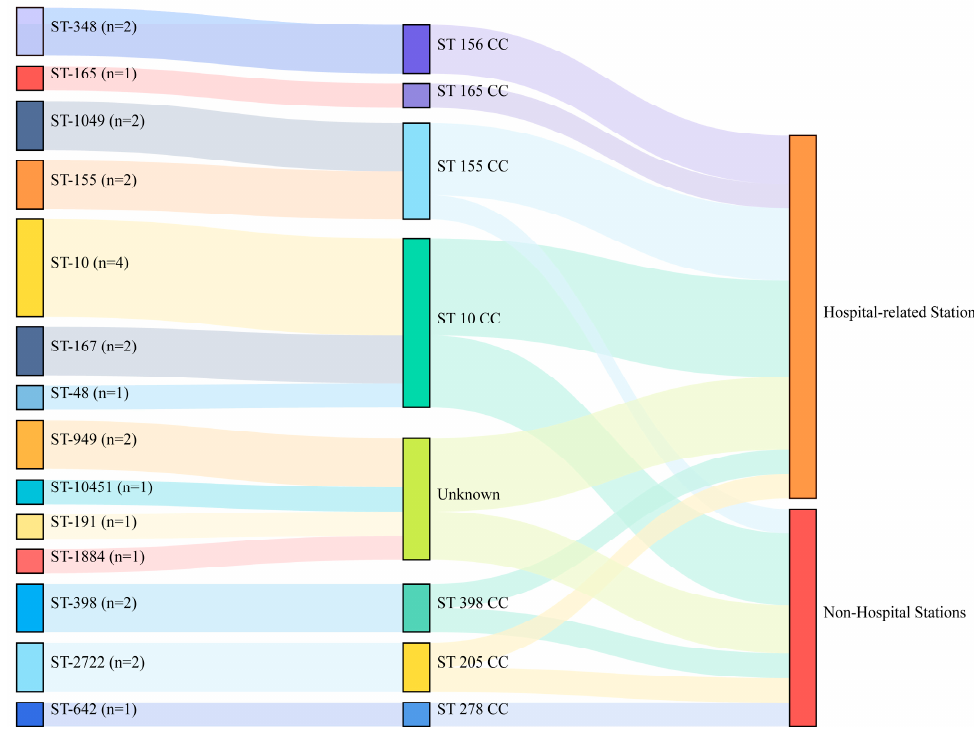
Figure 1. The distribution of STs from 24 E. coli in shared bikes. (CC: clonal complex, hospital-related stations represent Metro Stations nearing secondary/tertiary hospitals).